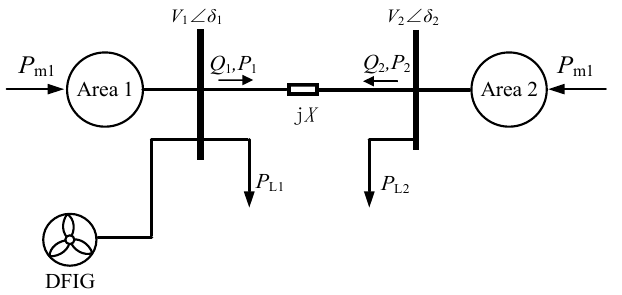
Figure 1. DFIG grid-connected system.